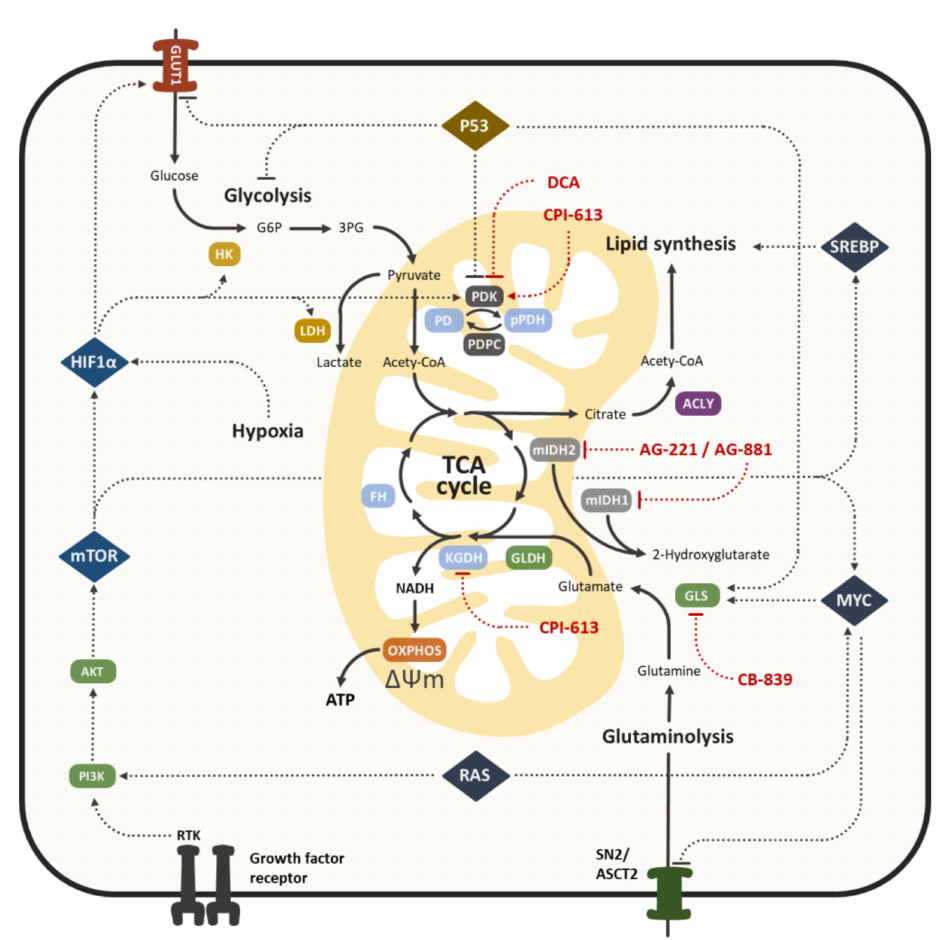
Figure 2. Oncogenic signaling and tumor suppressor activity in CRC cell metabolism. The metabolic pathways, centered around the TCA cycle, are indicated by continuous lines and include catabolic (glycolysis, OXPHOS), anabolic (lipid synthesis) and anaplerotic (glutaminolysis) reactions. Tumor suppressors (e.g., p53), oncogenes (e.g., RAS, MYC) and transcription factors (e.g., HIF1) regulate metabolic reprogramming by controlling the expression and activity of metabolic enzymes (e.g., HK, PDK, GLS) and transporters (e.g., GLUT1, SN2). Modulators of the TCA cycle (denoted in red), which are currently tested as chemotherapeutics in clinical trials, target di ff erent enzymes of the tumor cell metabolism (see chapter 3 for further